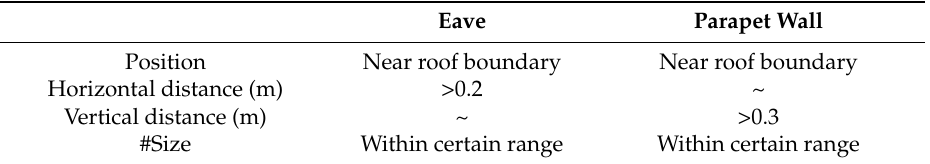
Table 3. Geometric features of the eaves and parapet